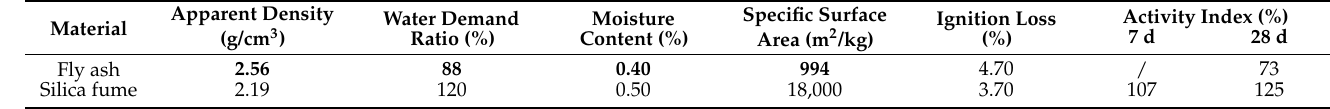
Figure 1. Particle size distribution of silica fume and fly ash. Table 2. Physical properties of fly ash and silica fume.